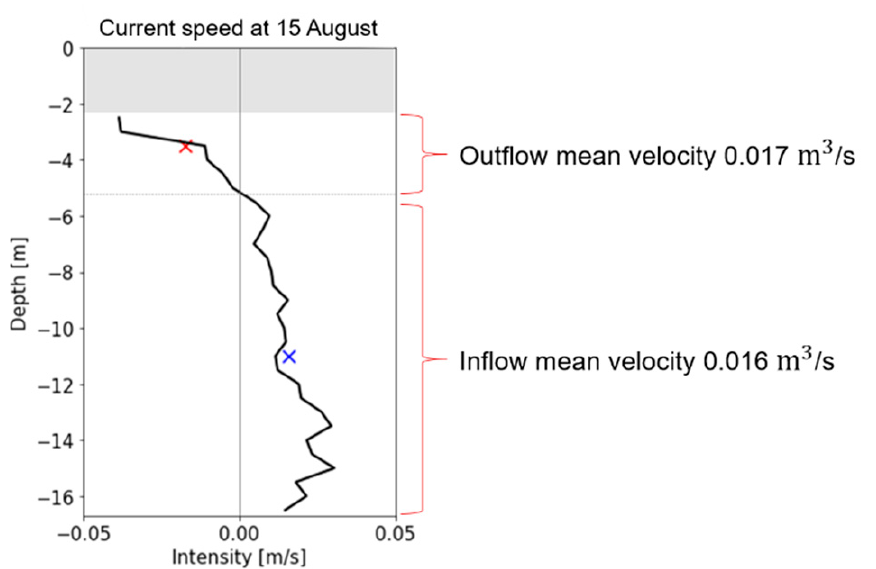
Figure 3. Vertical profile of the time averaged velocities at the Castellón harbour (in black). Averaged outflow (in red) and inflow (in blue) velocities, according to the second proposed approach.